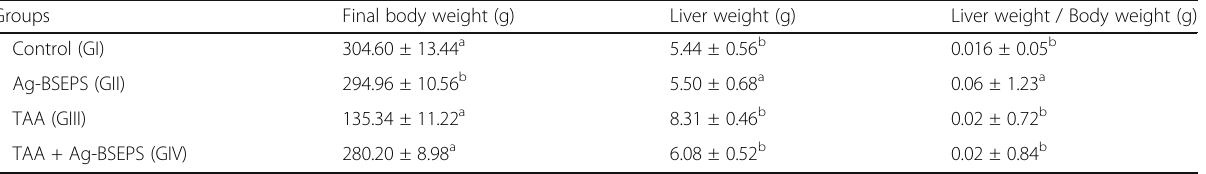
Table 1 Effect of Ag-BSEPS on body and liver weight before and after treatment Groups